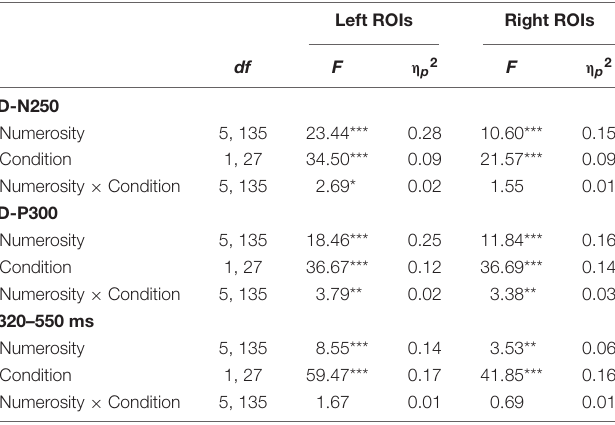
TABLE 3 | Mean amplitude two-way repeated measures ANOVA results for numerosity and condition effects on left and right regions of interest (ROIs) separately for each time